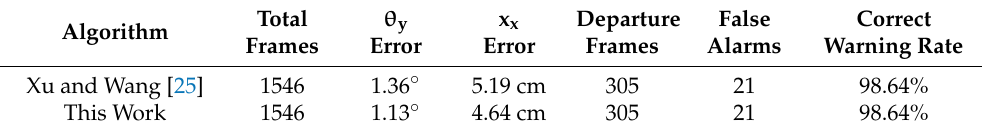
Table 3. Comparison of the proposed algorithm with [25] on lane departure warning.